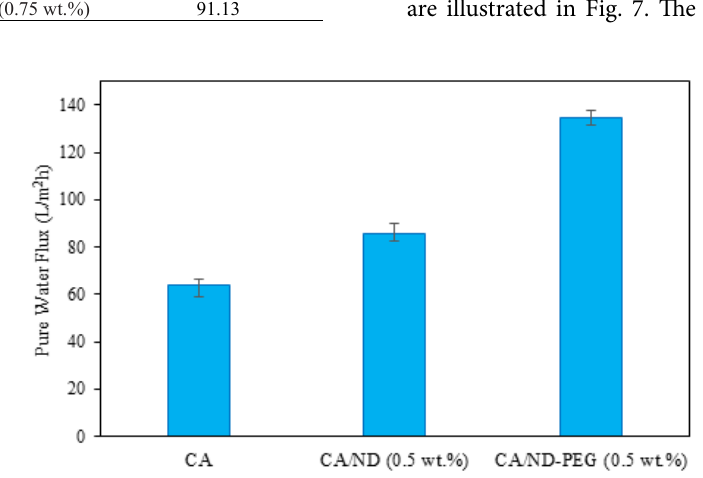
Fig. 7. Pure water flux of pure CA, CA/ND (0.5 wt.%), CA/ND-PEG (0.5 wt.%)